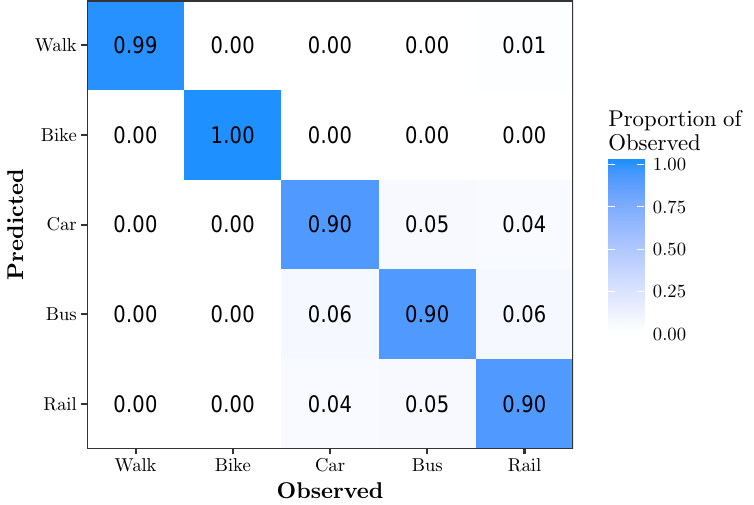
Figure 6. Confusion matrix for RFE- k NN{11}. This model has an overall accuracy of 93.7% using 7.9% of the